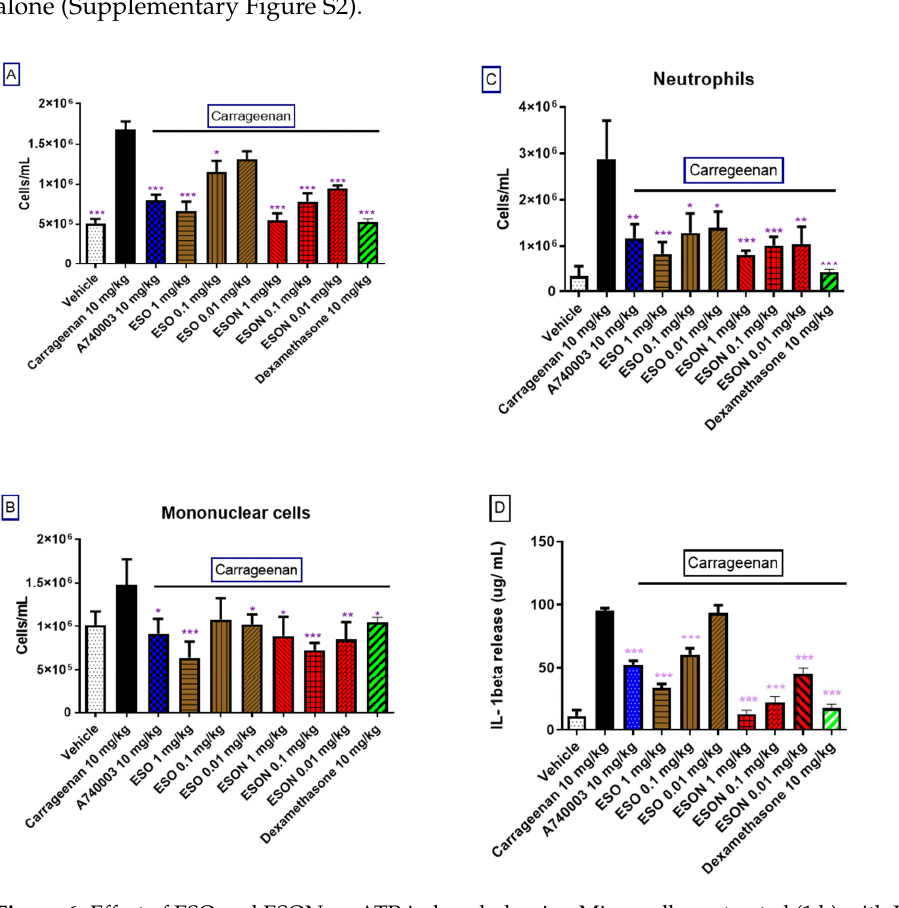
Figure 6. Effect of ESO and ESON on ATP-induced pleurisy. Mice orally pretreated (1 h) with ESO and ESON (1, 0.1, and 0,01 mg/kg), dexamethasone and A740003 (10 mg/kg) before carrageenan-challenge. ( A ) Total cellularity, ( B ) number of mononuclear cells, ( C ) number of neutrophils, and ( D ) level of IL-1β. The results are represented as the means ± SD from 4 assays on different days with five mice for each group. * p < 0.05; ** p < 0.01; *** p < 0.001 in comparison with the carrageenan